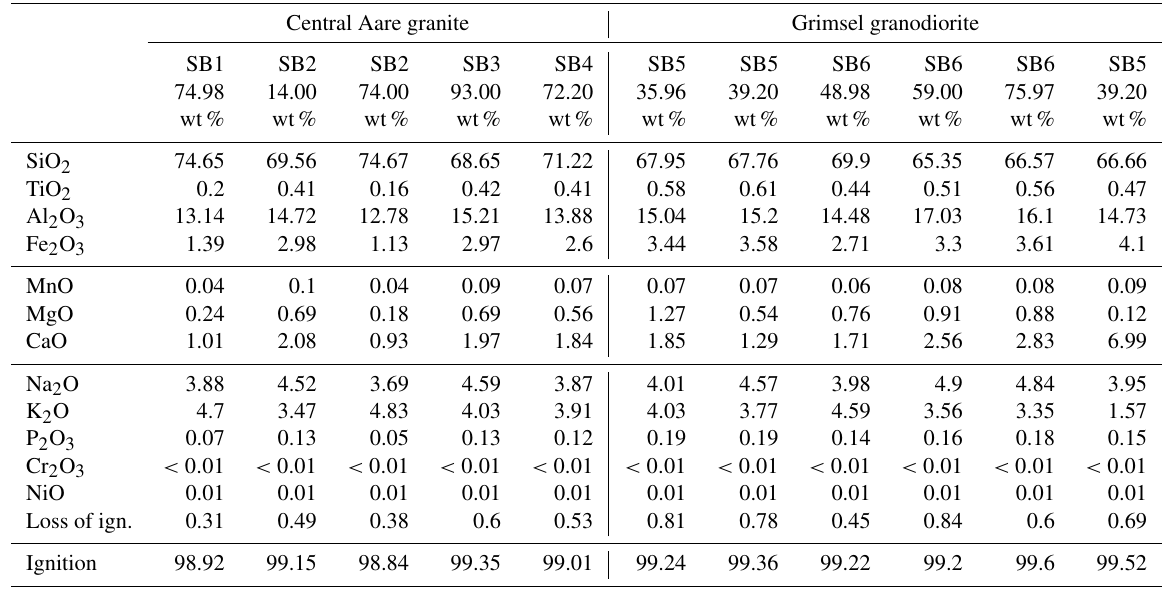
Table 2. Geochemical descriptions of the rock samples across the Grimsel test site given by Keusen et al. (1989). Central Aare granite Grimsel granodiorite